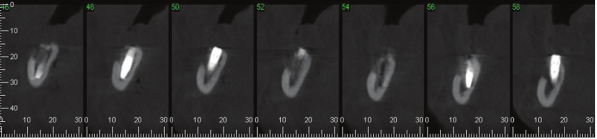
Figure 32: Computed tomography (cone beam) of the right